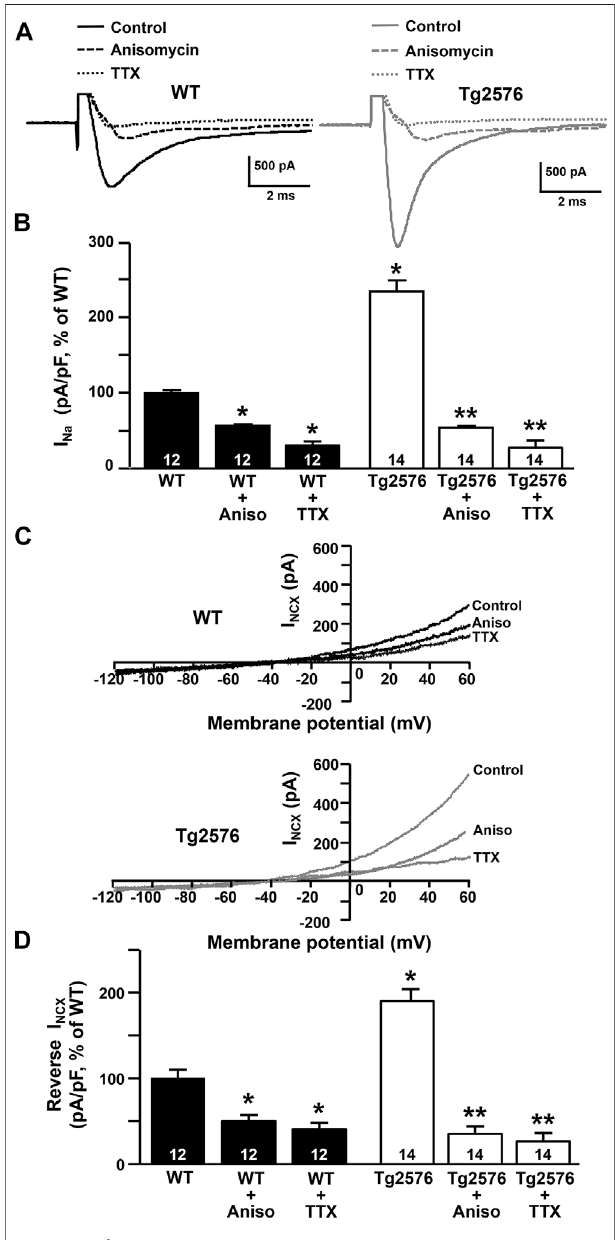
FIGURE 5 | Effect of TTX and anisomycin on I Na and I NCX in WT and Tg2576 primary hippocampal neurons. (A) Representative traces of I Na recorded in control conditions and in the presence of TTX or anisomycin pre- treatment in WT (black traces) and Tg2576 (grey traces) primary hippocampal neurons at 12 DIV. (B) Quanti fi cation of I Na represented in A, expressedaspercentageofWTincontrolconditions.Valuesareexpressedas mean ± SEM of 3 independent experimental sessions. (C) Representative superimposed traces of I NCX in the reverse and forward modes of operation recorded in control conditions and in the presence of TTX or anisomycin pre- treatmentin WT (top) and Tg2576 (bottom) primary hippocampal neuronsat 12DIV. (D) Quanti fi cationofI NCX inthereversemodeofoperationrepresented in C, expressed as percentage of WT in control conditions. Values are expressedasmean ± SEMof3independentexperimentalsessions.Statistical comparisons between groups were performed by one-way ANOVA followed by Newman-Keuls ’ test (* p < 0.05 vs. WT; ** p < 0.05 vs. Tg2576 mice). The number of cells used for each experimental condition is noted on the bars.